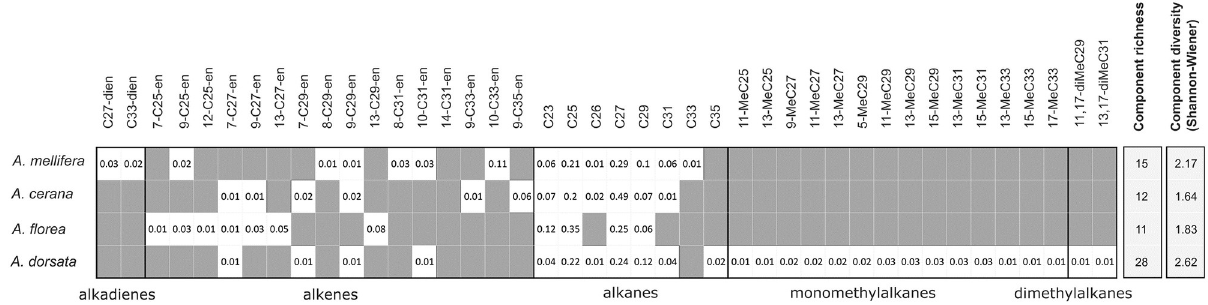
Fig 4. Survey on the components summarizing species-relevant factors. Honey bee species differ in their mean component richness and diversity (calculated according to Shannon-Wiener-Index). Additionally, abundances of single component are presented. The mean proportion of each component per species is given.